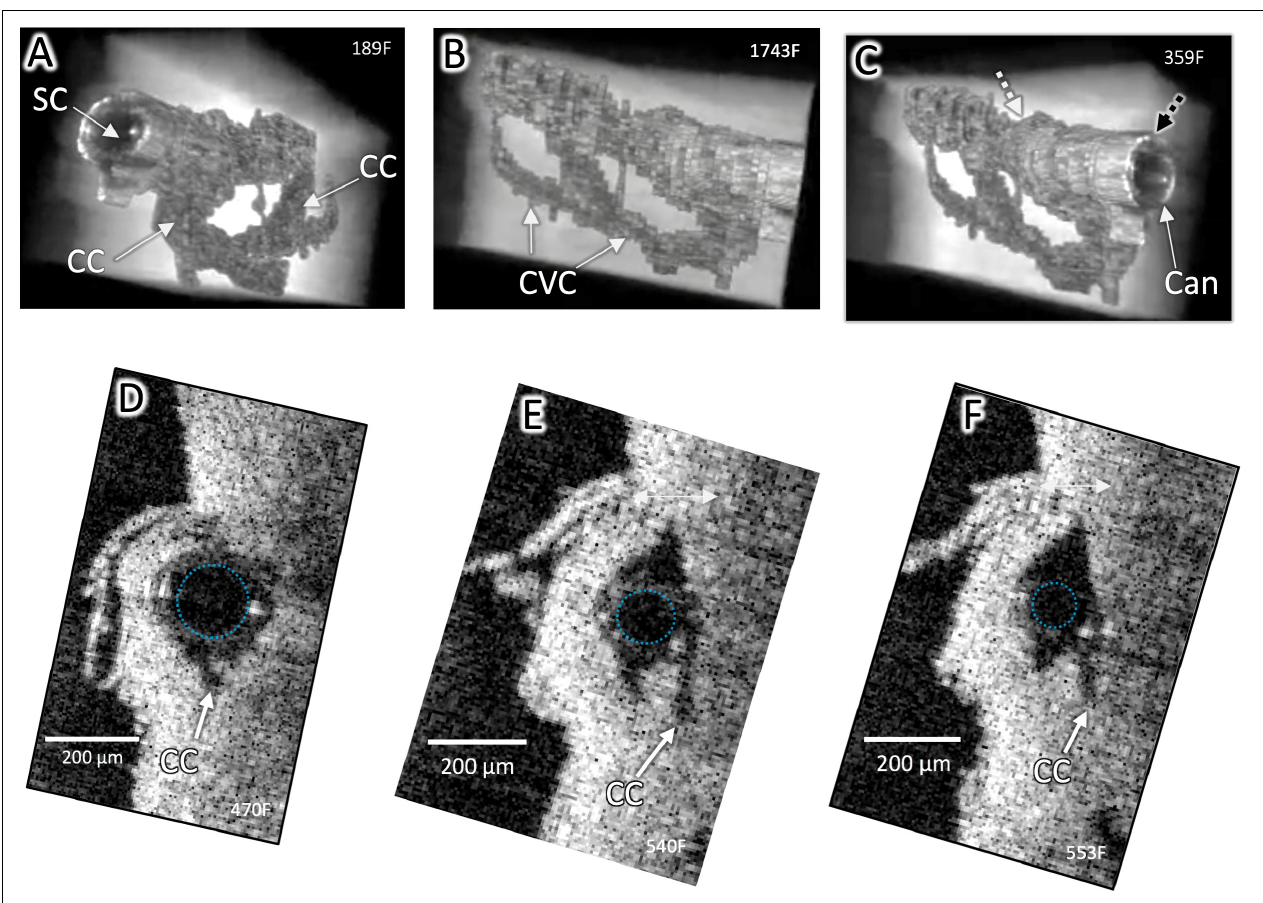
FIGURE 2 | Surface architecture and internal structure with a cannula in Schlemm’s canal. High-resolution OCT imaging permits delineation of the lumen boundaries of the outflow system after segmentation to eliminate surrounding structures in individual OCT B-scans and reconstruction with Amira 3D volumetric software. A cannula (Can) is visible in SC in (A–C) , and the cannula’s internal diameter is outlined in (D–F) . CC connect with an intrascleral circumferential-oriented vascular compartment (CVC) adjacent to and parallel with SC. Cannula location in (C) (Black dashed arrow) shown in cross-section in (D) . Location of end of cannula denoted by the white arrow in (C) and cross-section in (F) . The striped arrow distal to the cannula in (C) is the location of Figure 1 (B,C) . The outside diameter (OD) of the cannula at (C) was 241 µ m and at (D) was 178 µ m, typical of stent sizes and here occludes the CC entrance. Distally, the smaller cannula diameter no longer occludes CC. Both CC and CVC are distended distal and proximal to the cannula end, demonstrating a pathway for fluid entry to the distal system from the cannula end ( Supplementary Video 1